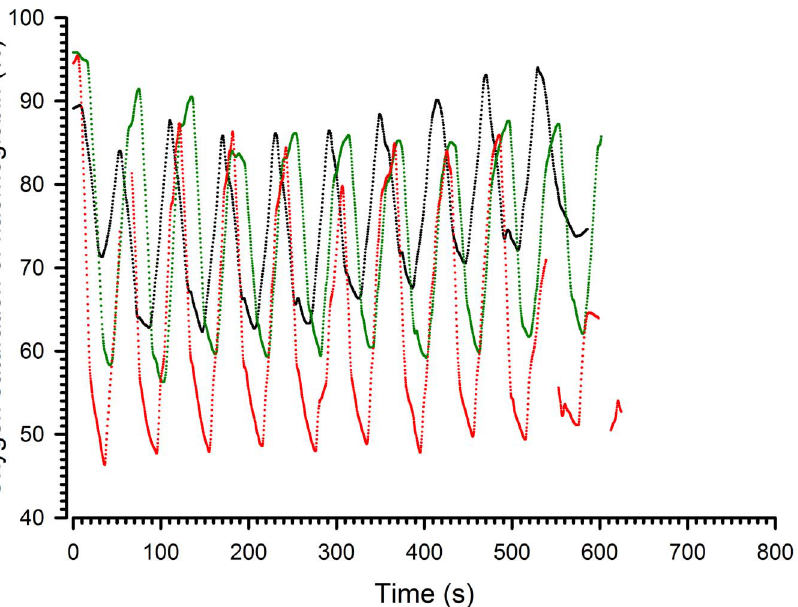
doi:10.1371/journal.pone.0059973.g007